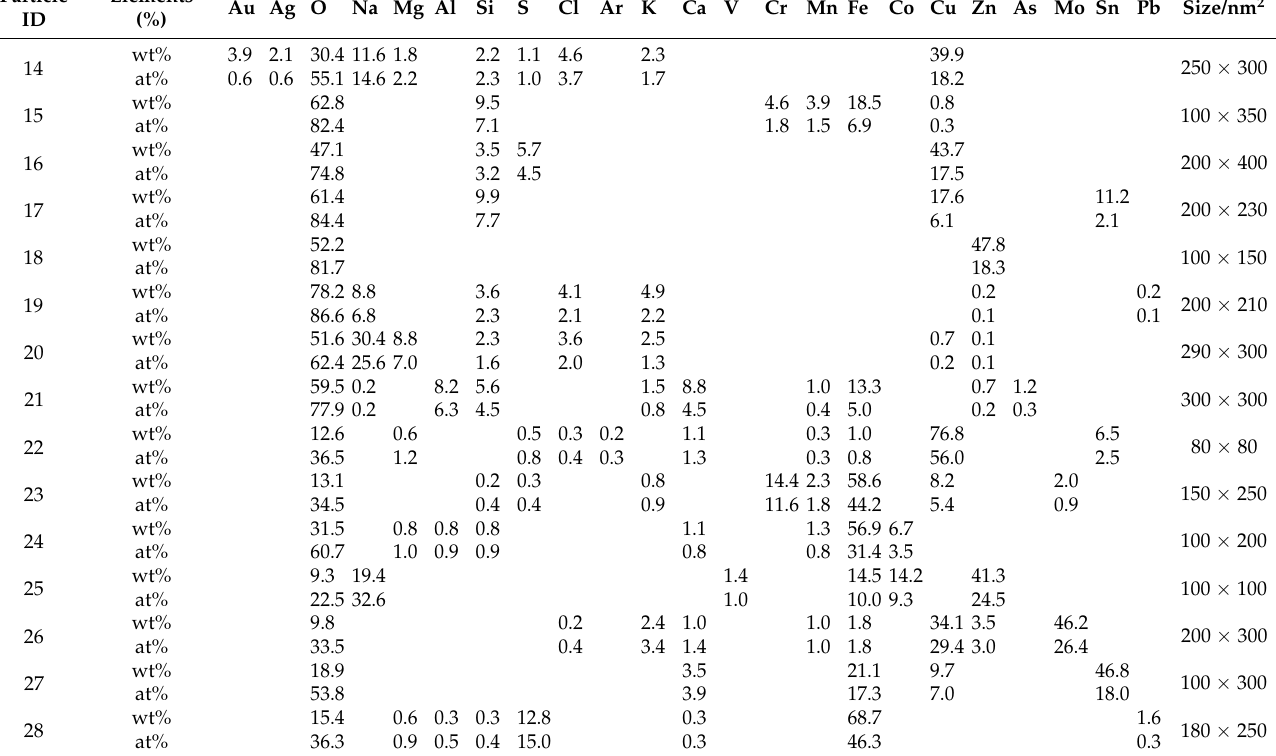
Table 3. The EDS data of particles and particle aggregations in soil (ID14-20) and shallow (ID21-24) and deep (ID25-28)